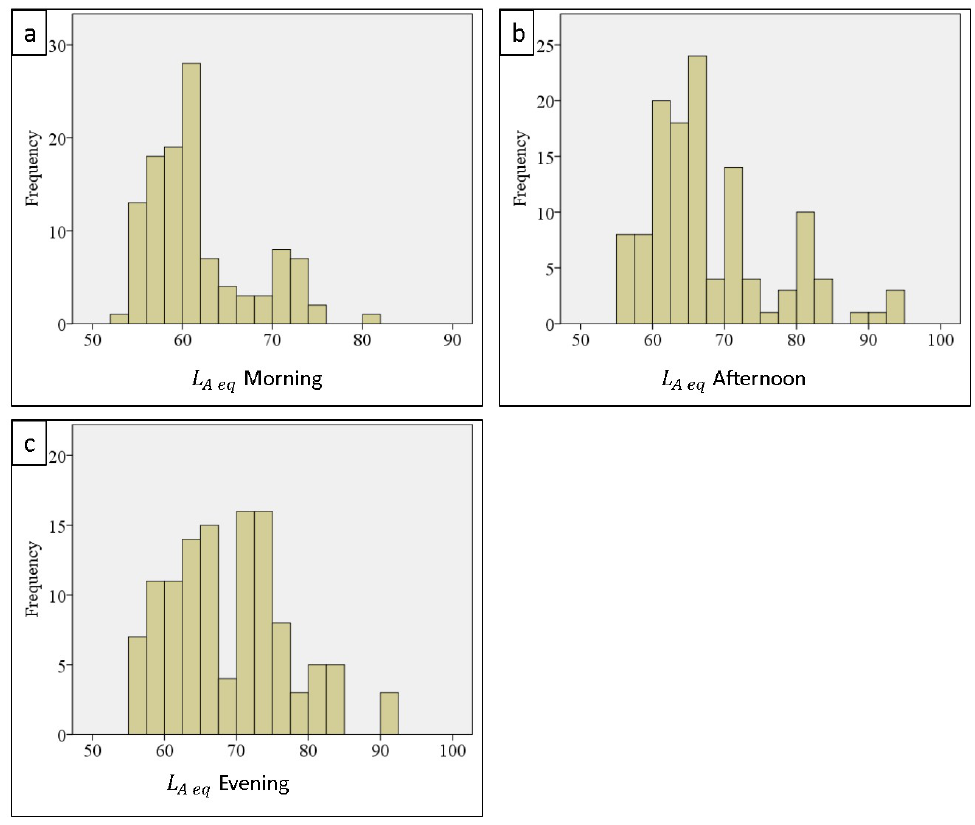
Figure 4: Variation in daily noise levels at the three periods of observation (a) morning (b) afternoon and (c) evening